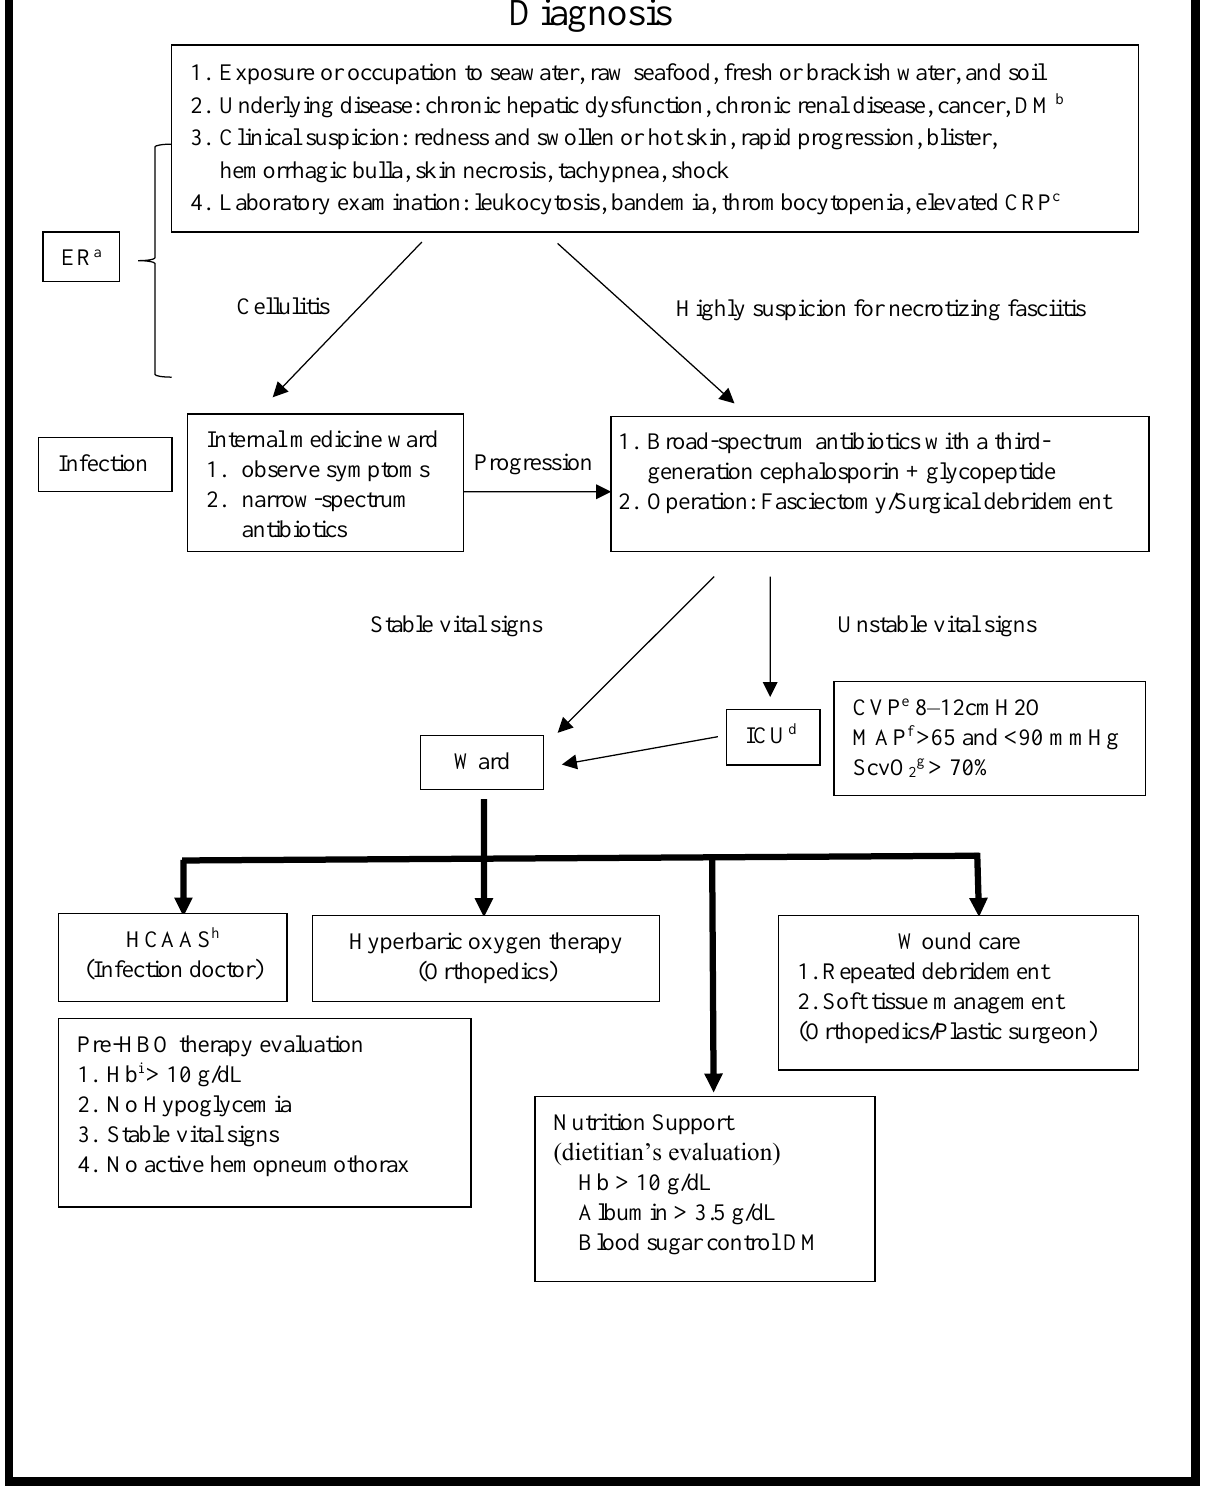
Figure 1. Diagnosis and treatment protocol of NF. NF, necrotizing fasciitis; a ER, emergency room; b DM, diabetes mellitus; c CRP, C-reactive protein; d ICU, intensive care unit; e CVP, central venous pressure; f MAP, mean arterial pressure; g ScvO 2 , central venous oxygen saturation; h HCAAS, hospital-wide computerized antimicrobial approval system; i Hb,